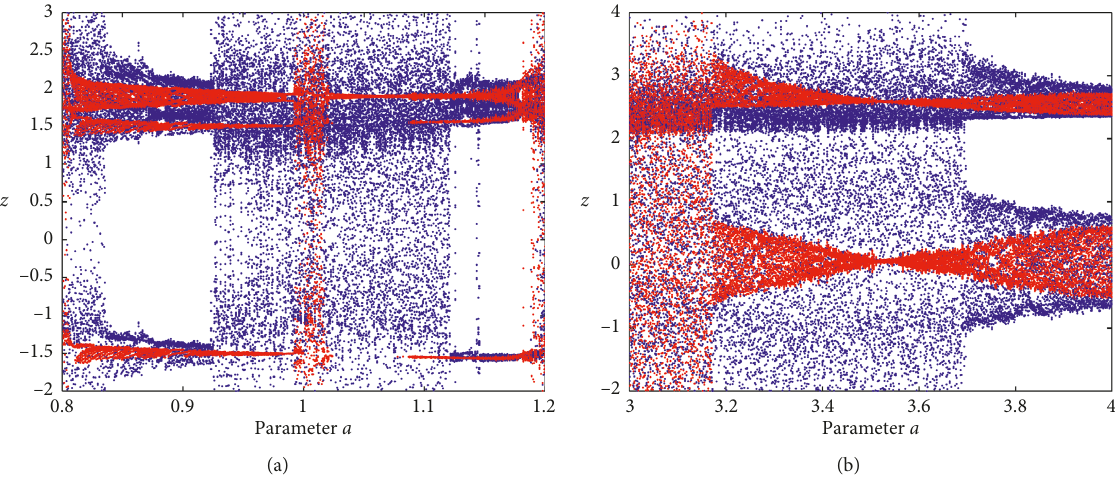
Figure 3: Enlargement of the bifurcation diagrams of Figure 2(a) in ranges of (a) [0.8, 1.2] and (b) [3, 4]; the initial conditions are (0.1, 0, 0) for blue diagrams and (0.2, 0, 0) for red diagrams.